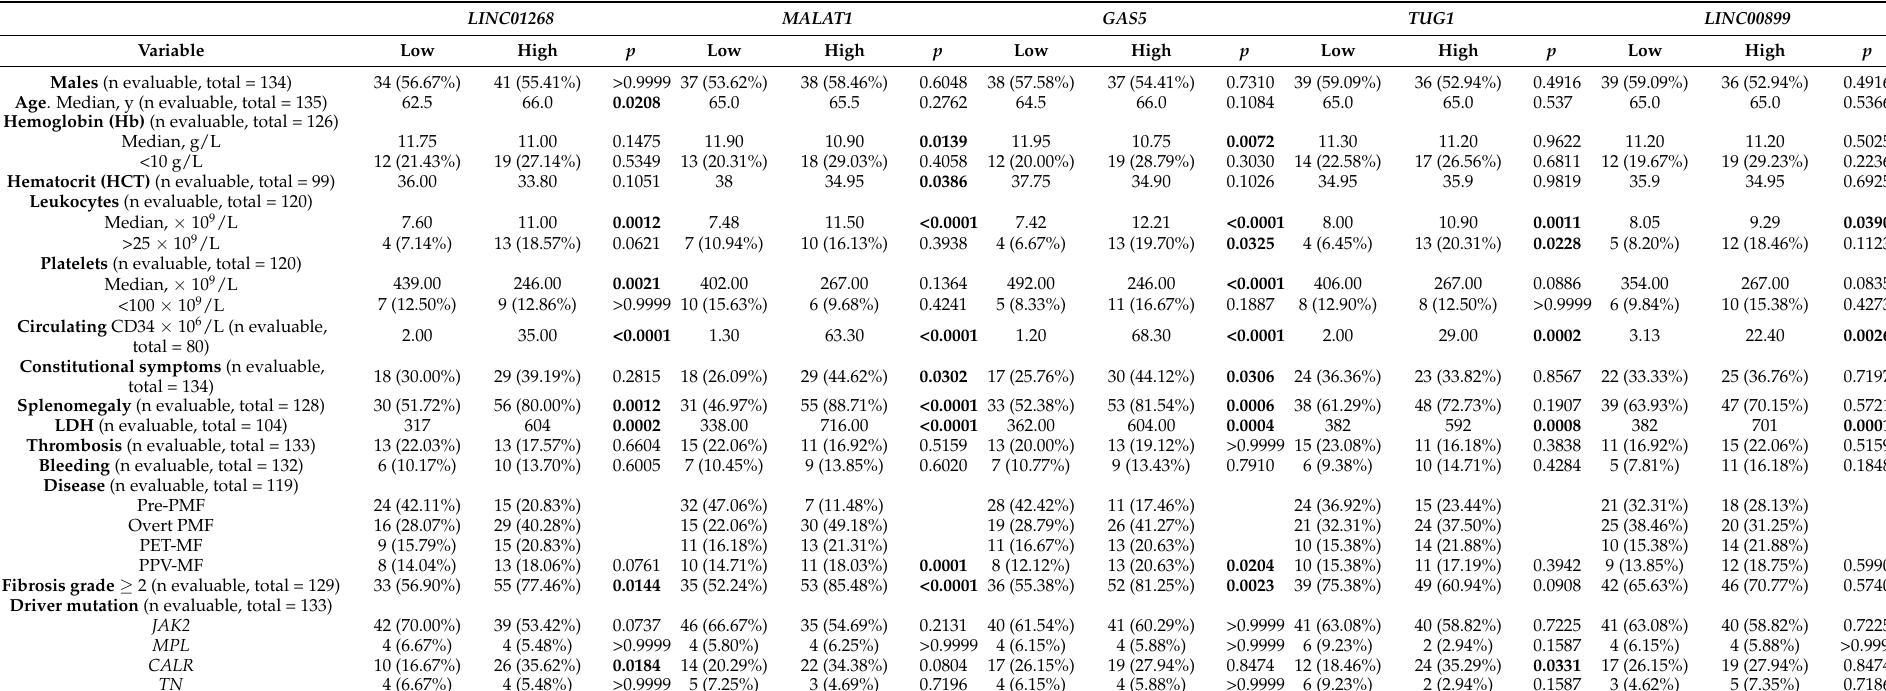
Table 1. Clinical and molecular features of MF patients included in our dataset, grouped according to the levels of single circulating lncRNAs. Data in the table are reported as n (%). p = p -value. N = evaluable samples. LDH = lactate dehydrogenase; DIPSS = Dynamic International Prognostic Score System. Significant p -value ( p < 0.05) are represented in bold. “—” = missing